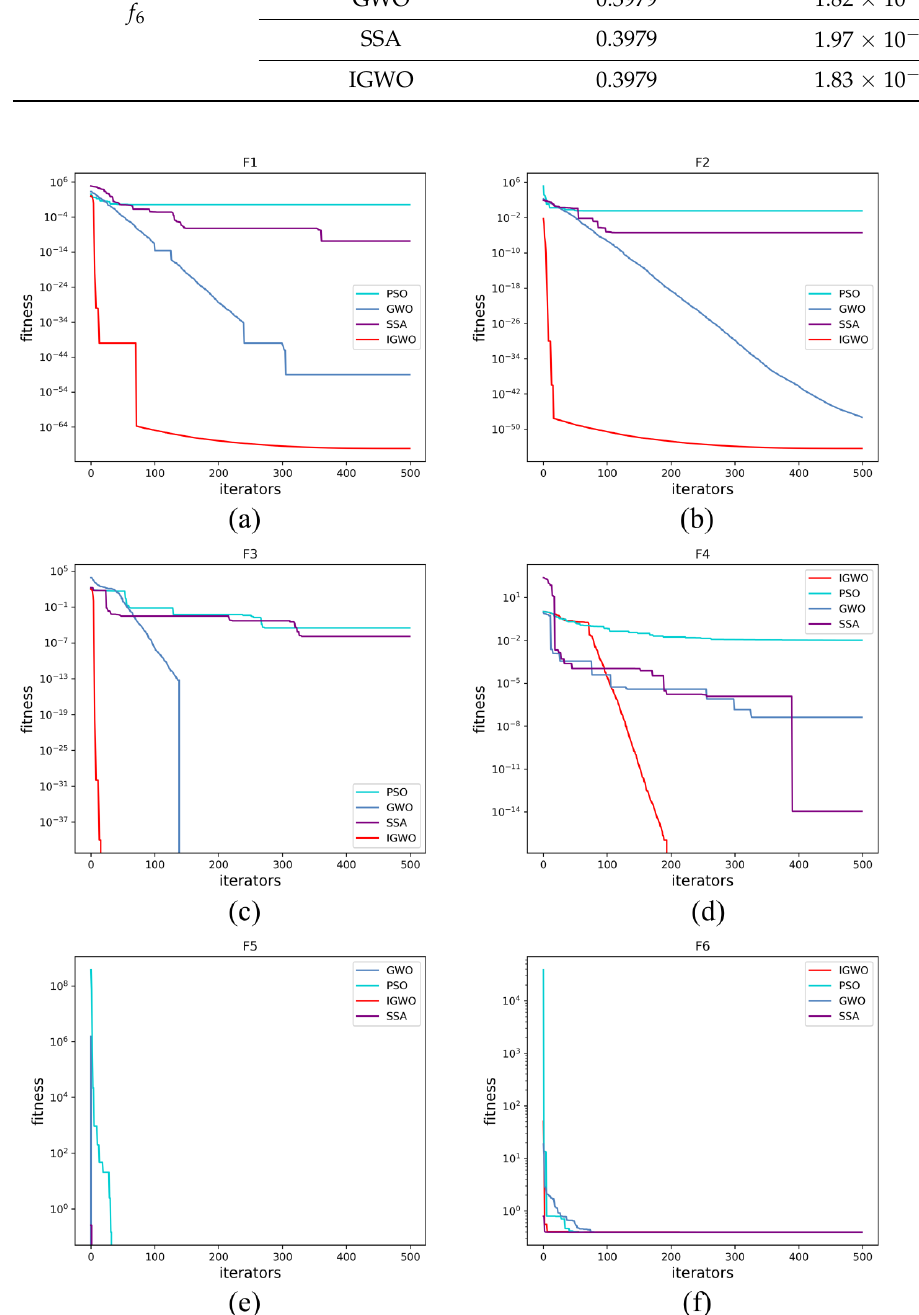
Figure 6. The convergence curves of algorithms on test functions. ( a ) 𝑓 1 function ； ( b ) 𝑓 2 func- tion ； ( c ) 𝑓 3 function ； ( d ) 𝑓 4 function ； ( e ) 𝑓 5 function ； ( f ) 𝑓 6 function.